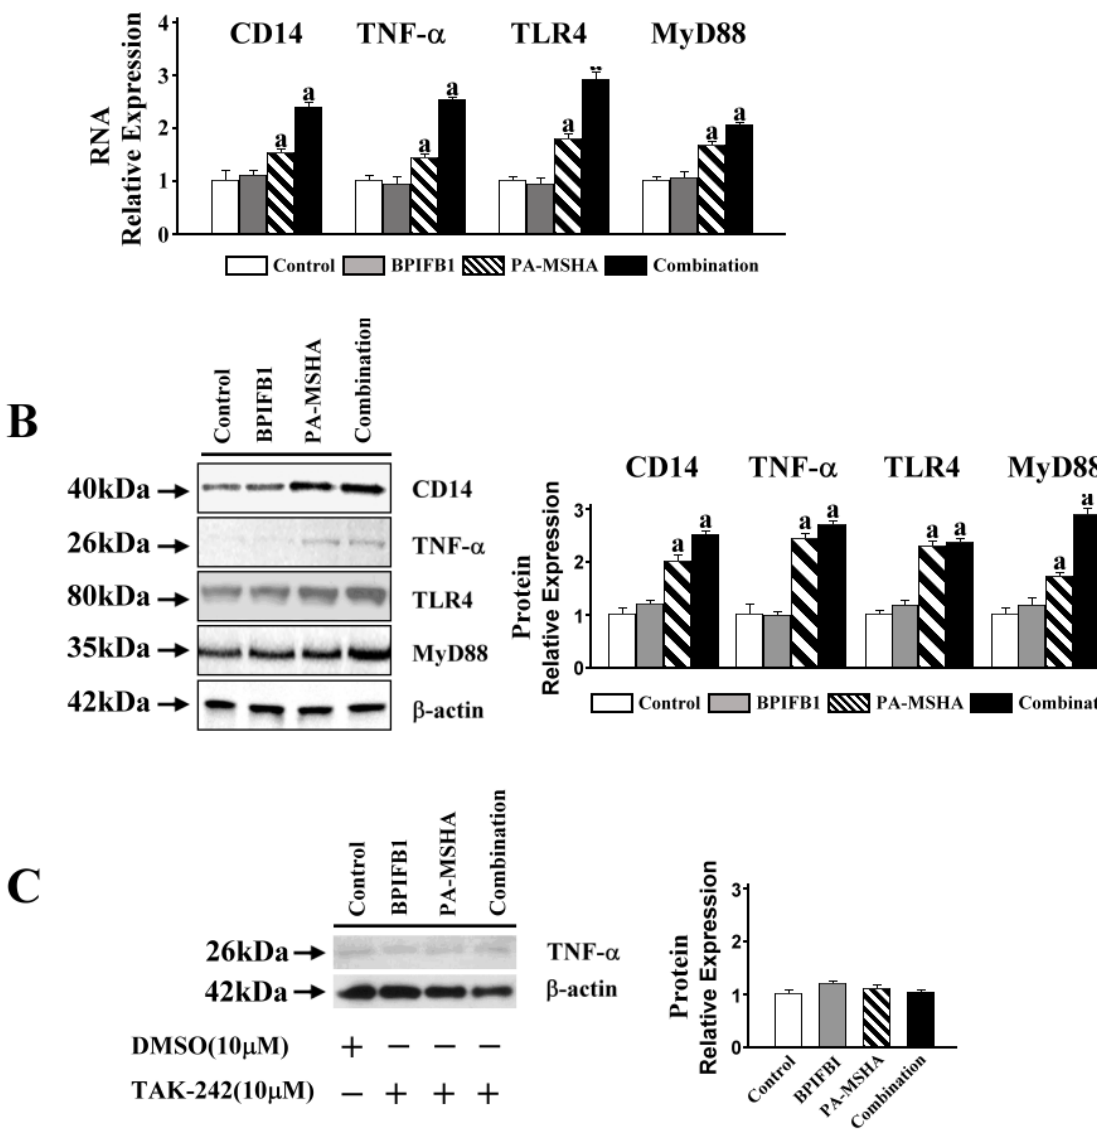
Figure 2: CD14/TLR4/MyD88 pathway contributed to the PA-MSHA-BPIFB1 signaling transduction. A. 5 × 10 5 /ml differentiated THP-1 cells were treated with 2 × 10 7 /ml of PA-MSHA and 1 mg/ml BPIFB1 for 24 hours. RNA was extracted and